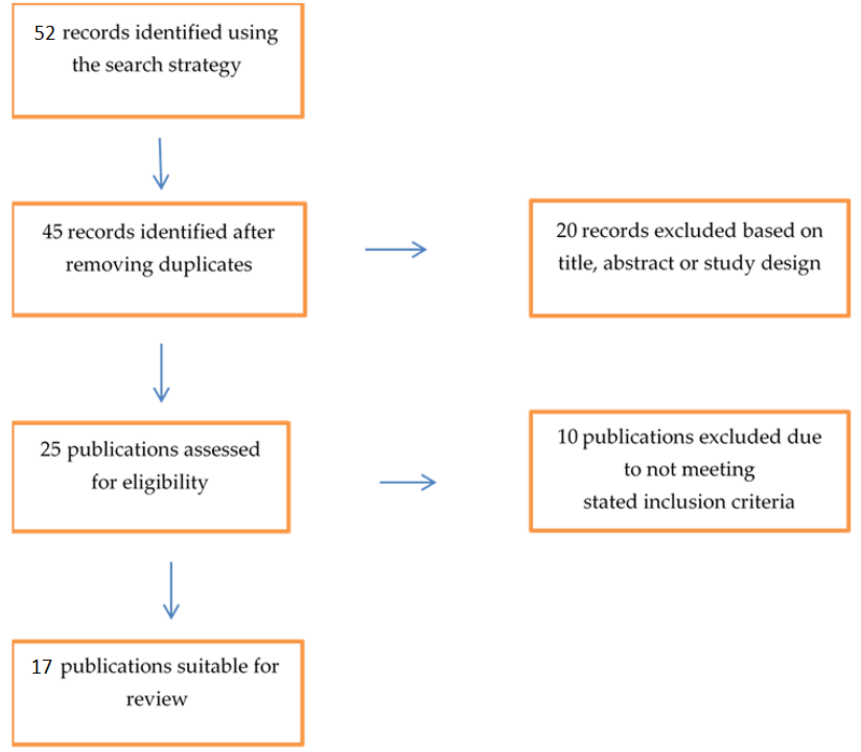
Figure 1. Study flow chart. The flow chart summarizes how the articles were reviewed and catego- rized based on risk assessment, risk management, and occurrence rates topics.